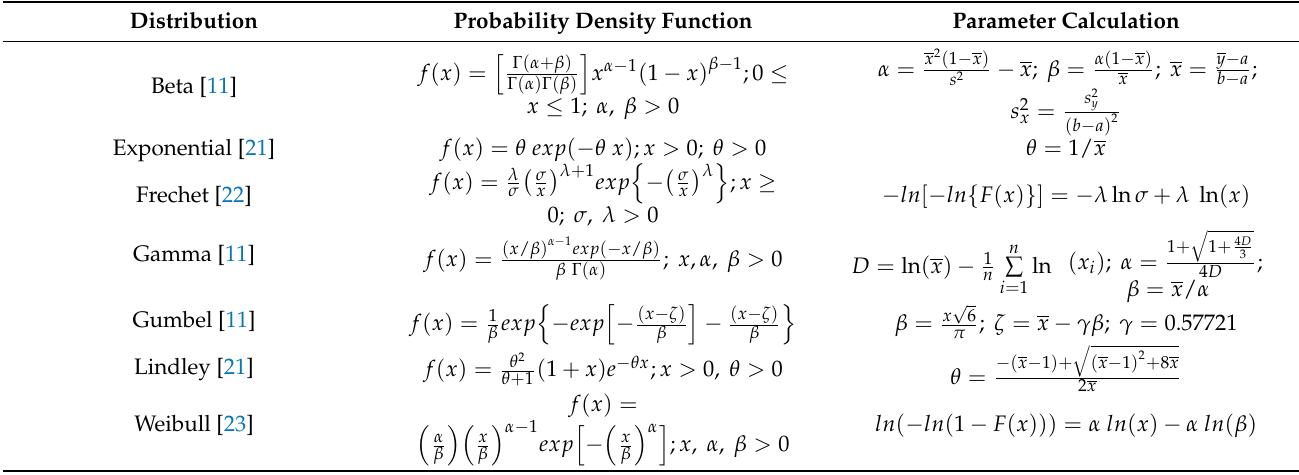
Table 1. Skewed distributions used in the current study.